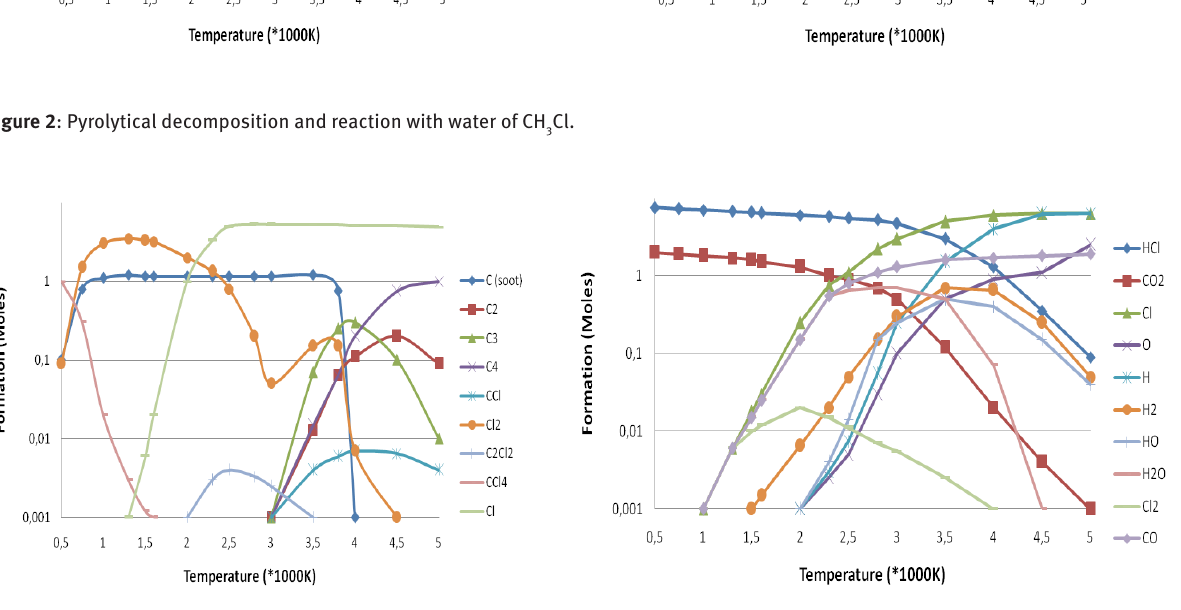
Figure 3 : Pyrolytical decomposition and reaction with water of CCl